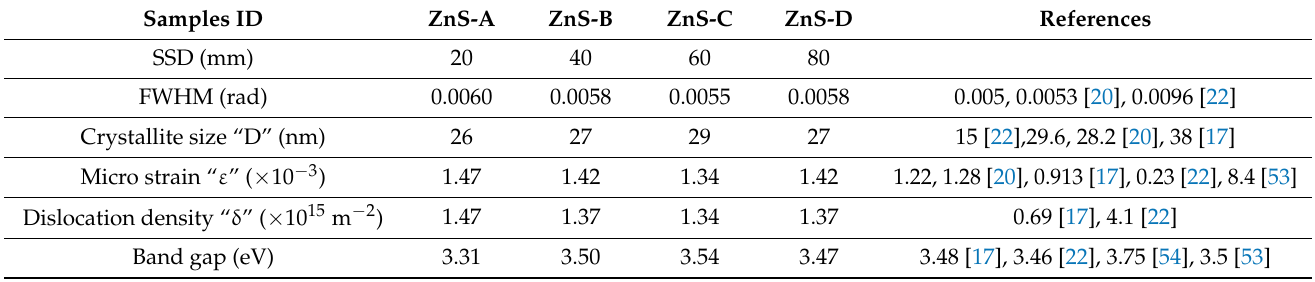
Table 1. Structural parameters by XRD data and optical bandgaps by Tauc’s plot method were ob- tained.